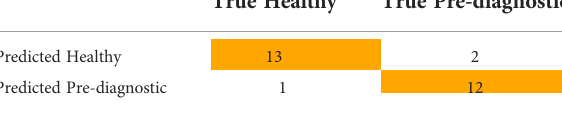
TABLE 2 Confusion matrix for classi fi cation of 28 CT scans of the external set consisting of 14 from each of Healthy control and Pre- diagnostic group.